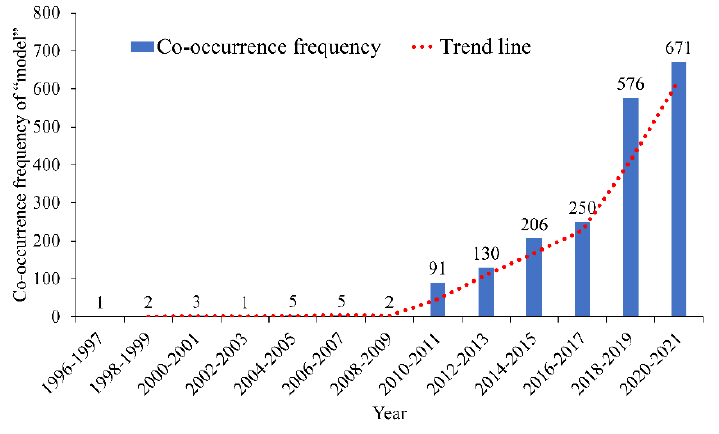
Figure 2. Co-occurrence frequency and time distribution of